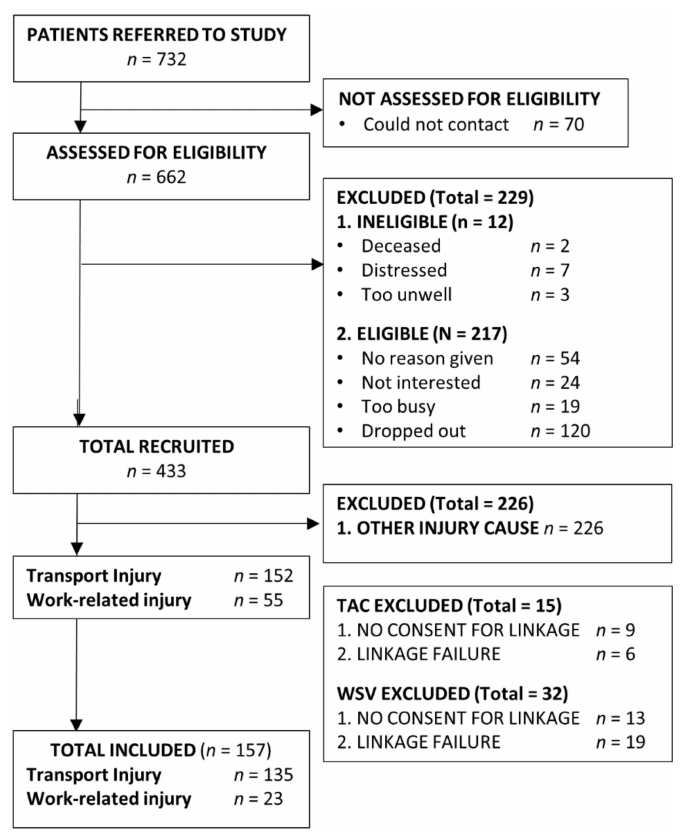
Figure 1. Participant recruitment flow chart. Note: One participant had both Transport Accident Commission (TAC) and WorkSafe Victoria (WSV) claims